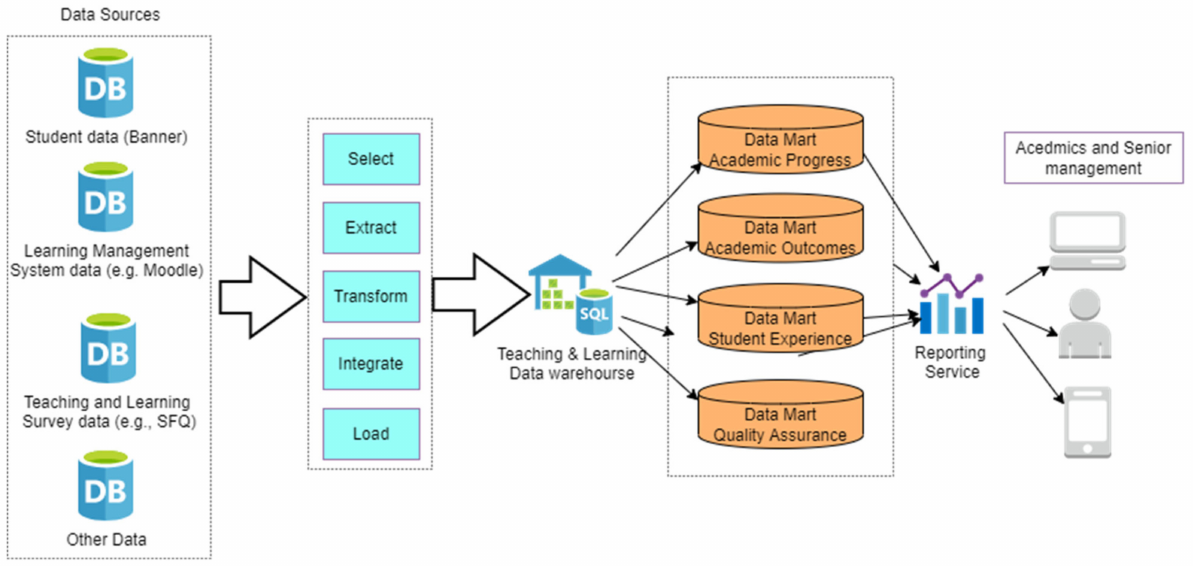
Figure 6. The data flow in the data warehouse in this